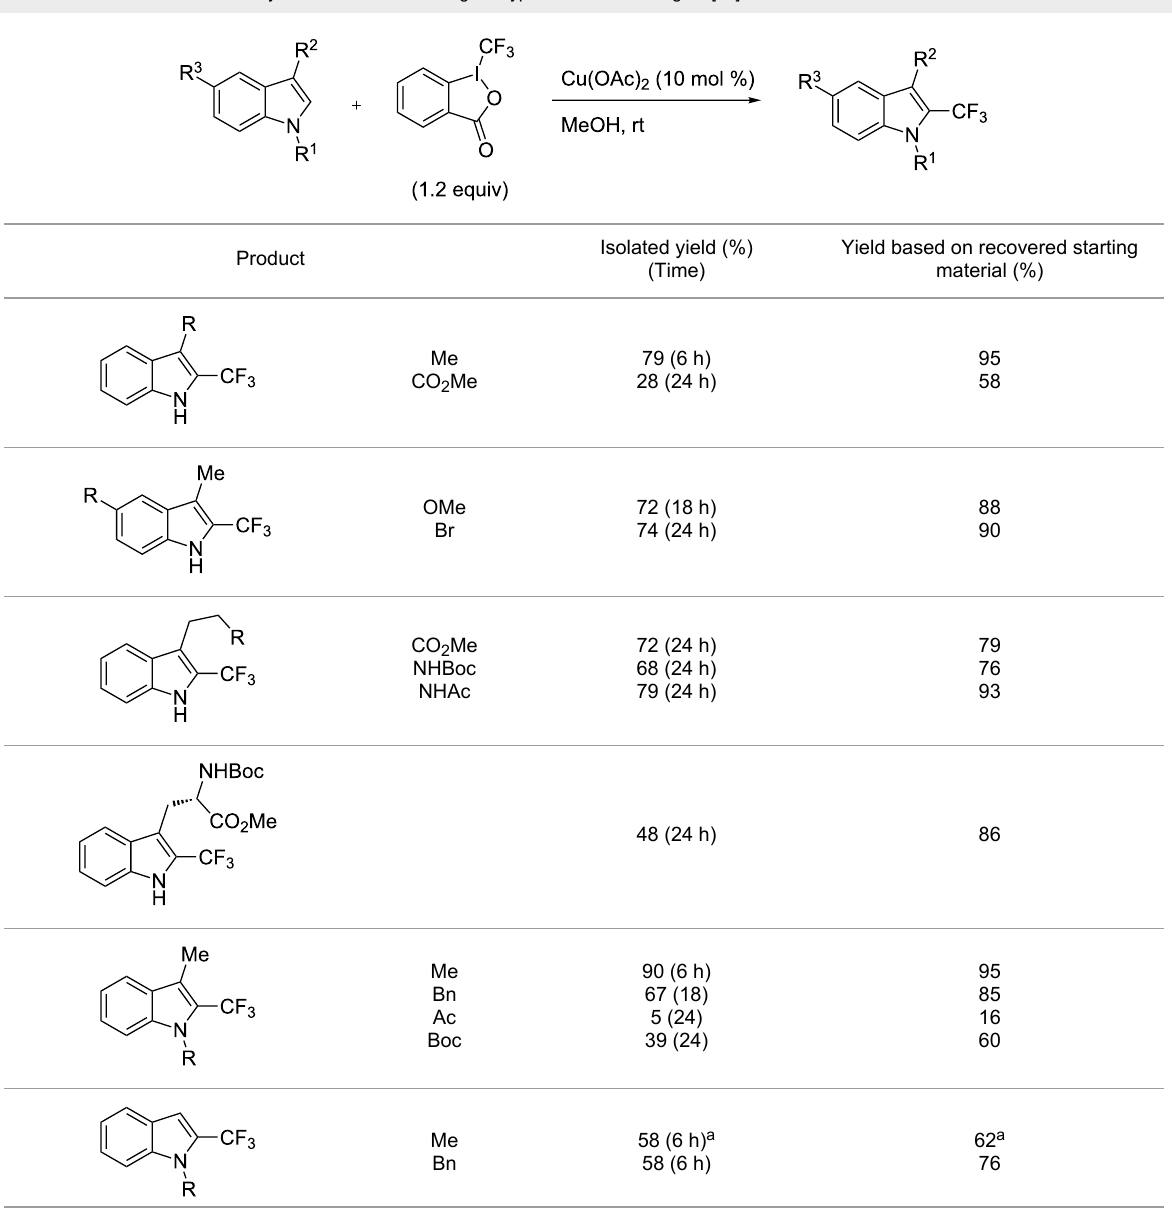
Table 16: Sodeoka’s trifluoromethylation of indoles with Togni’s hypervalent iodine reagent